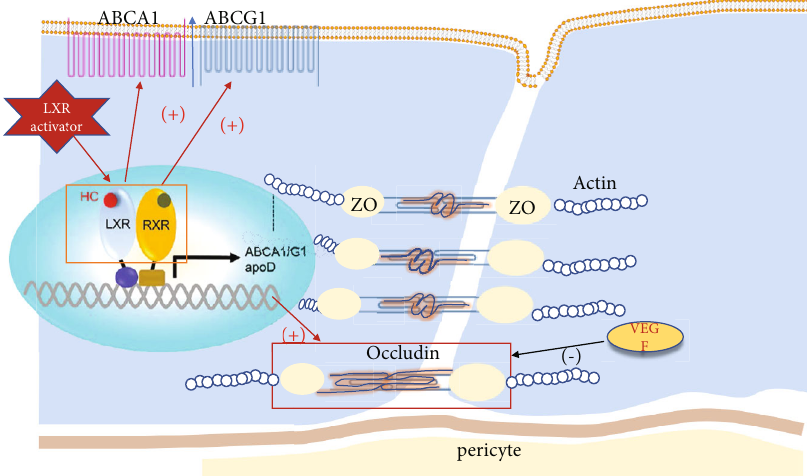
Figure 1: Liver X receptor perturbations of lipid metabolism in diabetic retinopathy. Under normal physiological conditions, transcriptional activity of LXRs is increased in response to elevated cellular levels of cholesterol. A high glucose environment attenuates activation of LXR, inducing the downregulations of transporters ABCA1 and ABCG1 on the cell membrane. Consequence of cellular cholesterol accumulation causes oxidative stress and in fl ammation in vascular endothelial cells. Furthermore, the increased expression level of VEGF downregulates tight junction proteins ZO-1 and occludin, leading to blood-retinal breakdown. LXR agonists can eventually reverse this pathological process. LXR: liver X receptor; RXR: retinoid X receptor; ABCA1: ATP-binding cassette subfamily A member 1; ABCG1: ATP-binding cassette subfamily G member 1; apo: apolipoprotein; ZO-1: zonula